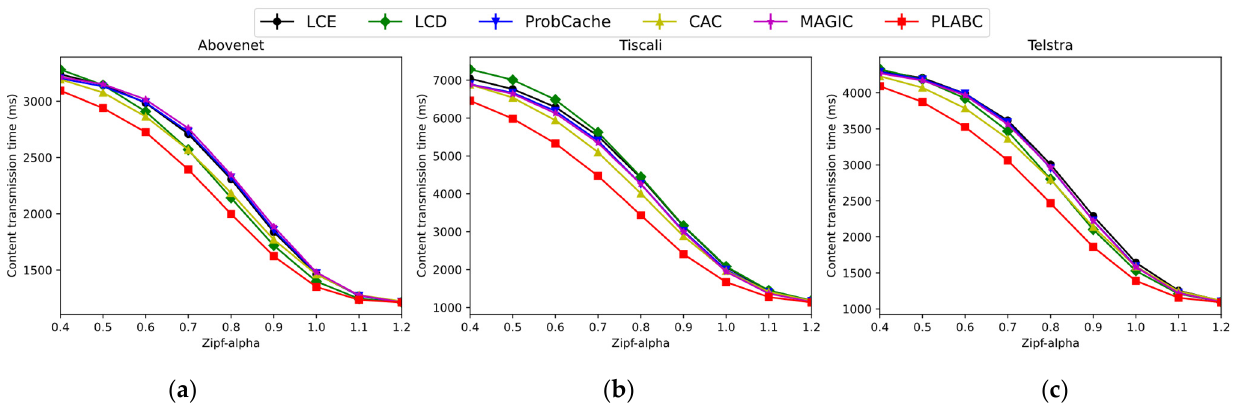
Figure 19. Average content transmission time results of different caching strategies when Zipf exponent alpha varies under topology: ( a ) Abovenet; ( b ) Tiscali; ( c ) Telstra.